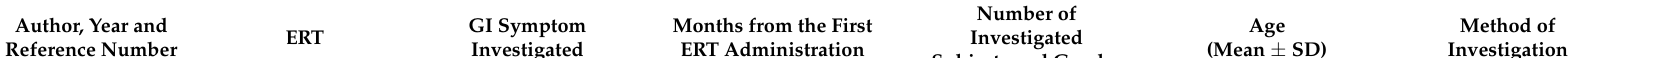
Table 1. Studies investigating the effect of enzyme replacement therapy (ERT) on gastrointestinal (GI)